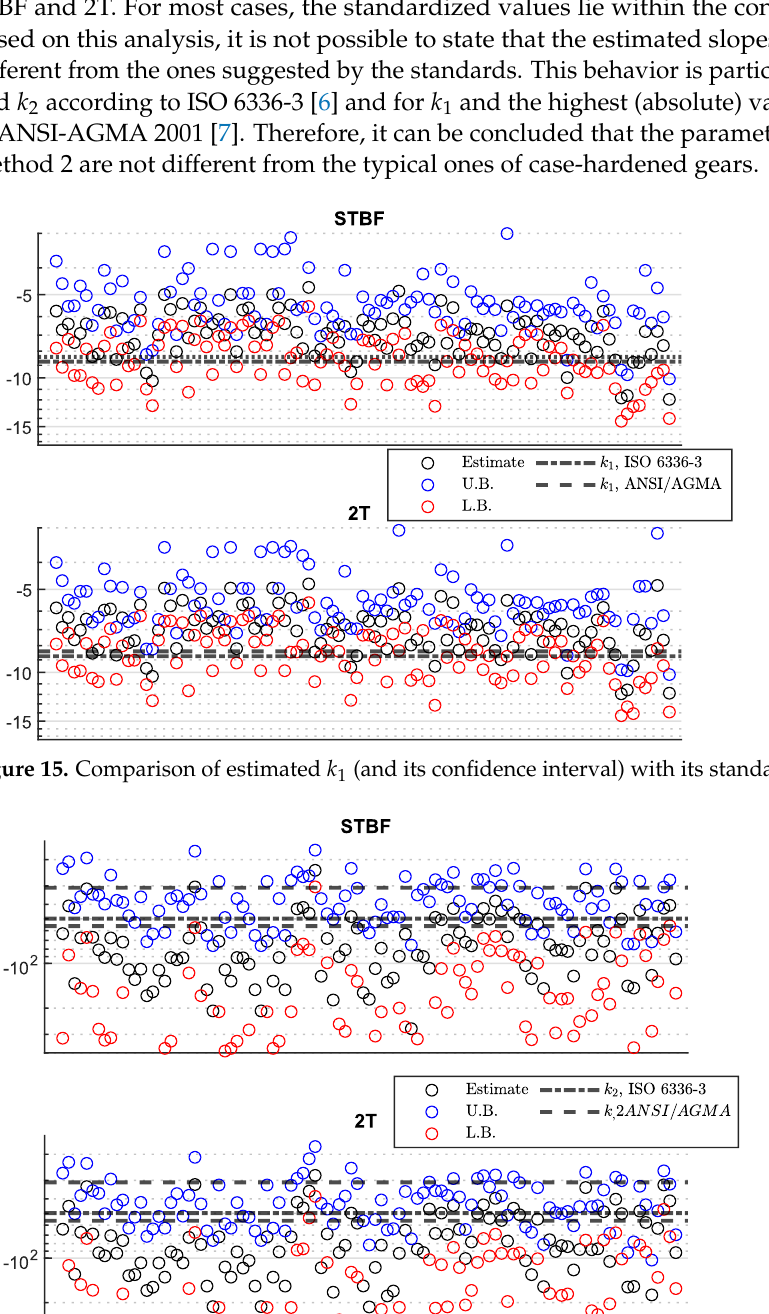
Figure 16. Comparison of estimated